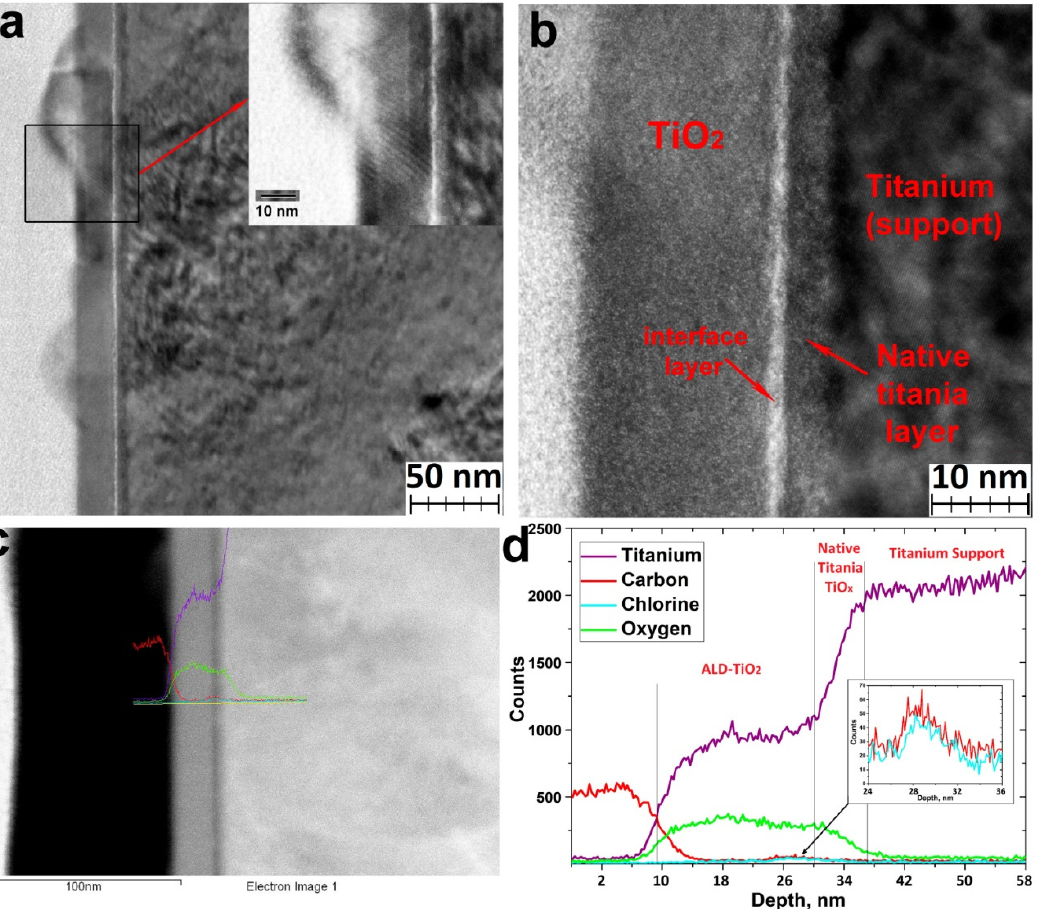
Figure 6. TEM images of TiO 2 coatings deposited on the UFG titanium using TiCl 4 and H 2 O at 200 ° С ( a , b ), STEM images ( c ), and STEM-EDS profile of elemental composition ( d ).